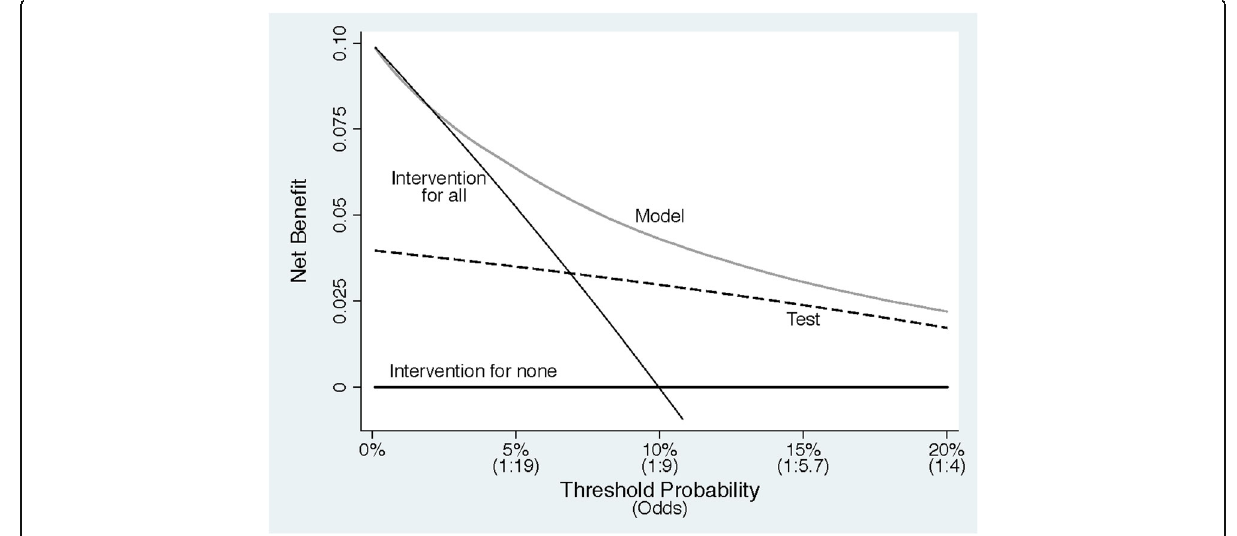
Fig. 2 A decision curve plotting net benefit against threshold